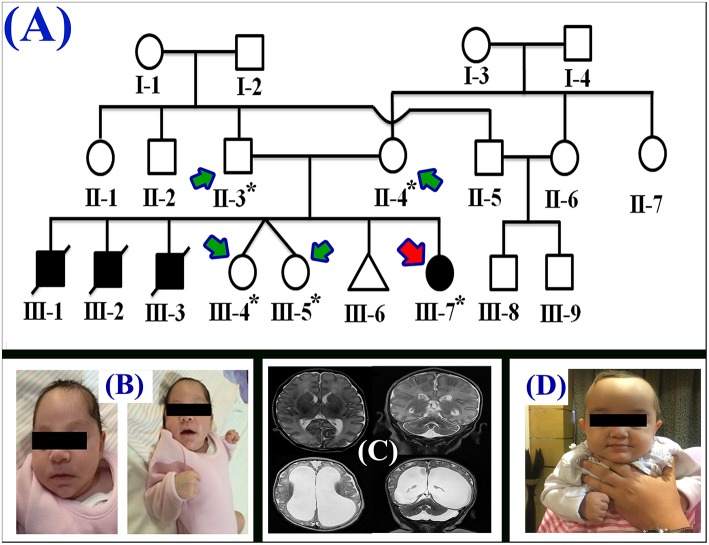
(A) Pedigree of the family segregating severe MTHFR deficiency. Pedigree clearly depicts an autosomal recessive mode of inheritance. Circles and squares represent females and males, respectively. Clear symbols represent normal, while filled symbols represent affected individuals. Slashes represents deceased individuals and triangle represents spontaneous abortion (SAB). The individual numbers labeled with asterisks were subjected to WES and the red arrow indicates the proband. (B) Pictures of the affected individual exhibiting microcephalic features at 1 month of age. (C) Brain MRI showing axial, coronal, and both T2 weighted images. These images revealed bilateral abnormal and symmetrical high signal intensity along the bilateral frontal horn in white matter, and the superior part of the periventricular deep white matter as well as within the subcortical basal temporal lobe white matter. The images also showed severely dilated ventricles and loss of white matter in cerebral hemispheres with prominent extra-axial CSF spaces. (D) A recent photograph of the proband (III-7) showing severe MTHFR deficiency.